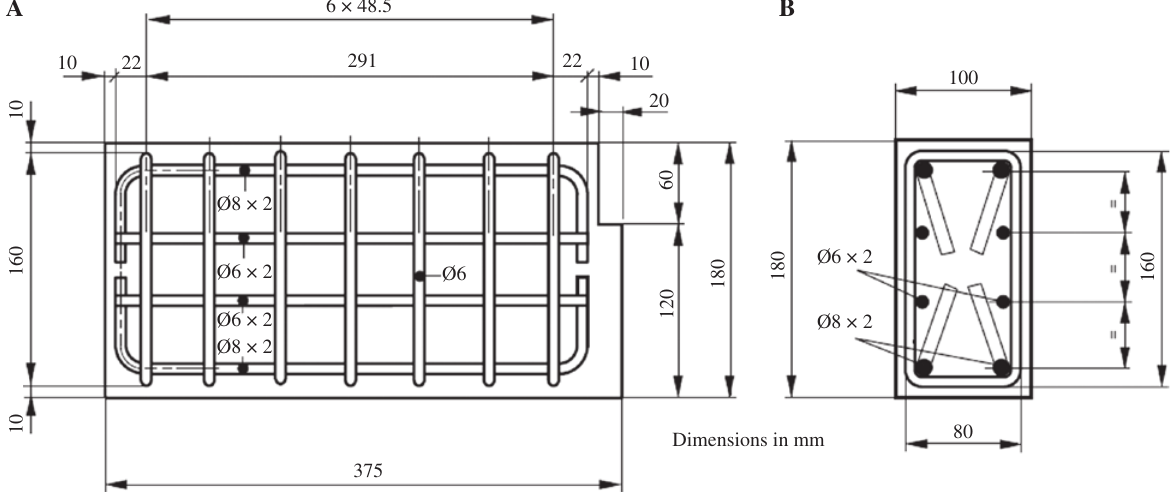
Figure 5: Reinforcement arrangement of the hinged beam blocks used in this research [20].